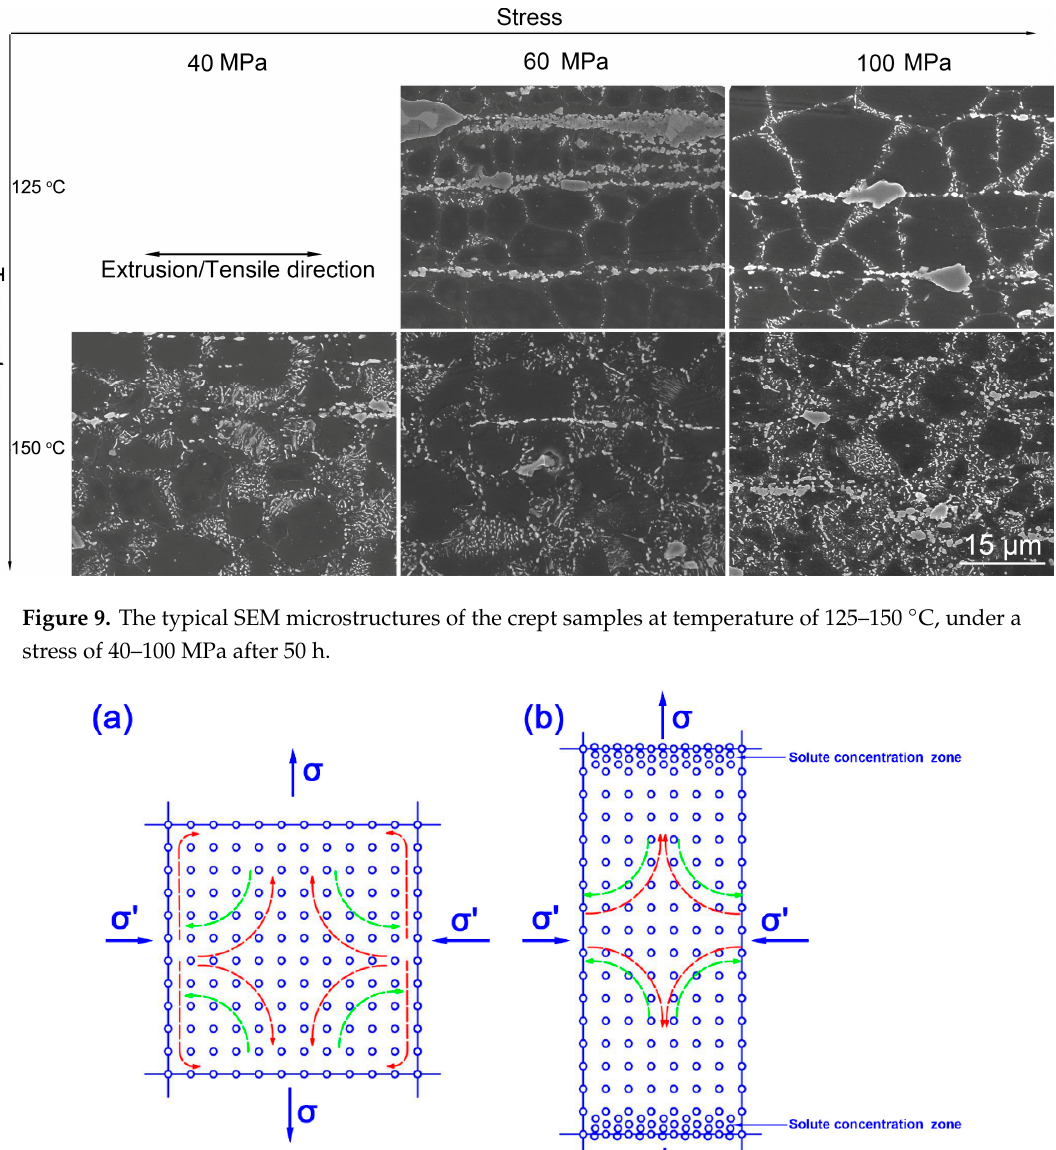
Figure 11. A detailed SEM micrograph of the crept sample under the condition of 125 °C/100 MPa.